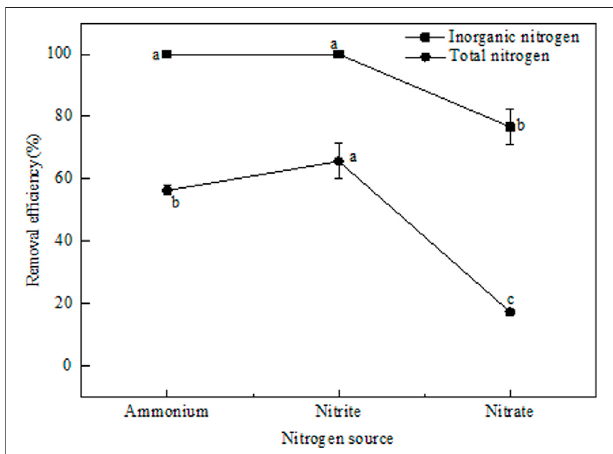
FIGURE 3 | Nitrogen removal ef fi ciency of strain EM-AI under aerobic conditions using ammonium and nitrite as sole nitrogen source. Values are presented as the means ± SD of the results of three replicates (error bars). Different letters indicate signi fi cant differences between treatments at p < 0.05.